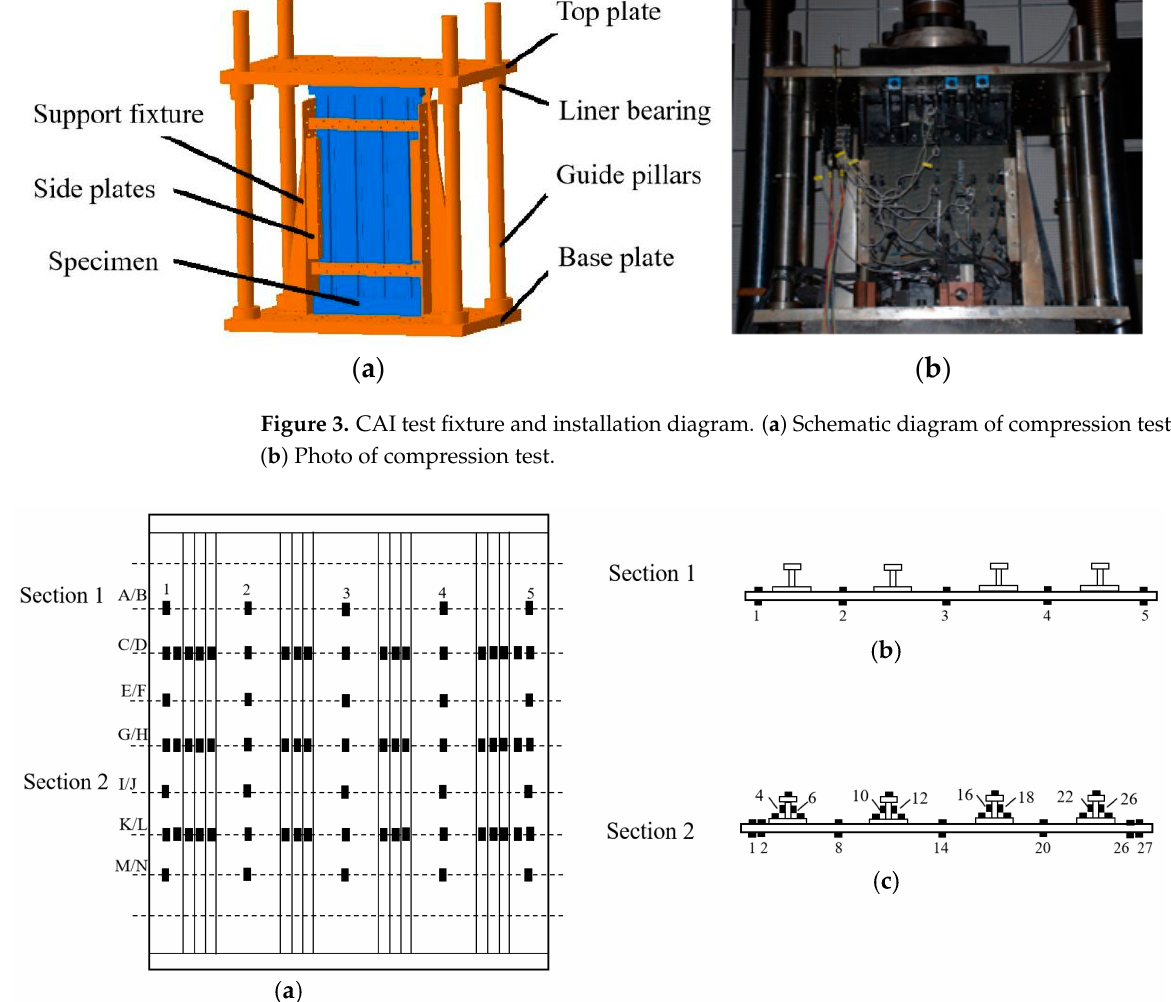
Figure 4. Location of strain gauges. ( a ) Distribution map; ( b ) Cross A/B, E/F, I/J and M/N; ( c ) Cross C/D, G/H and